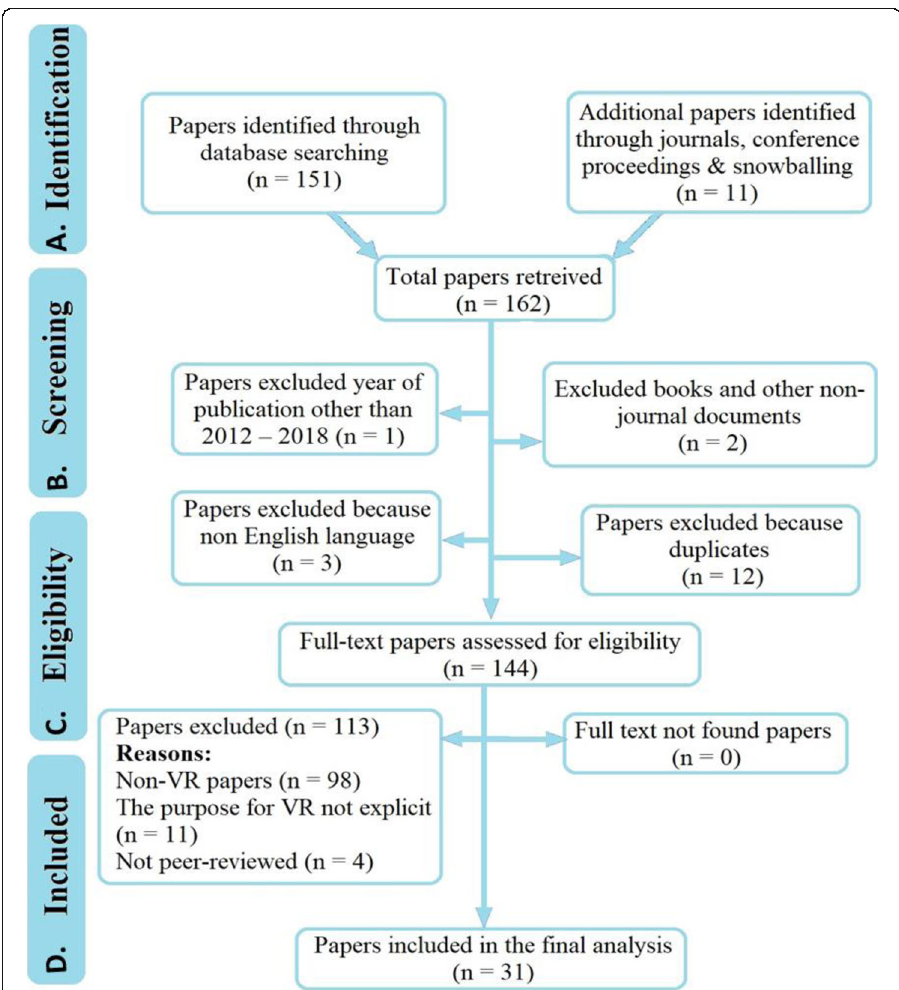
Fig. 2 Flow Diagram of the Review Process (Adapted from Moher, Liberati, Tetzlaff, & Altman,